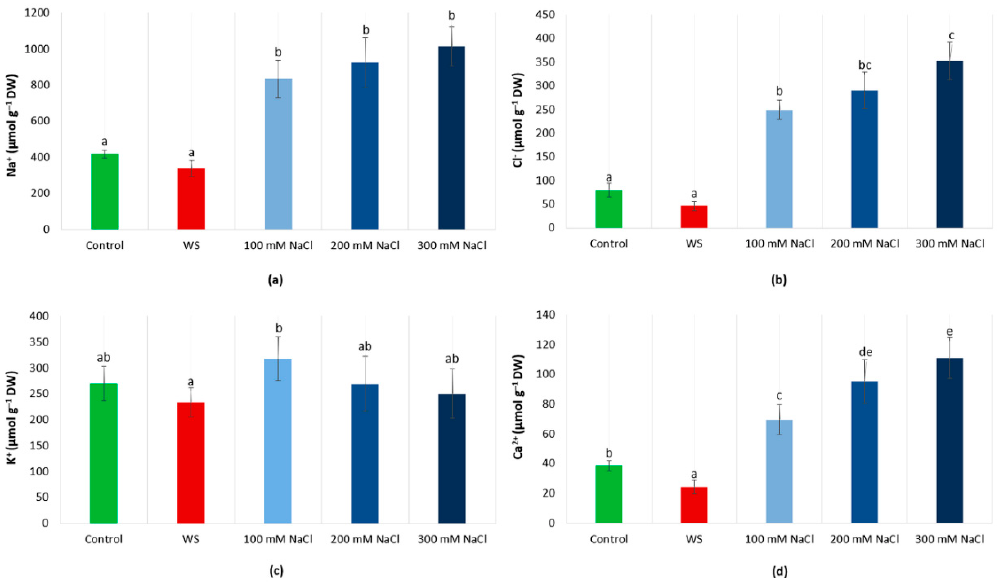
Figure 4. Ion contents in needles of one-year-old A. alba seedlings after 30 days of growth in the presence of the indicated NaCl concentrations or subjected to water deficit stress (WS). ( a ) sodium, ( b ) chloride, ( c ) potassium, ( d ) calcium. Bars represent means ± SE ( n = 7). Different letters above the bars indicate significant differences between treatments, according to Tukey’s test ( α = 0.05).